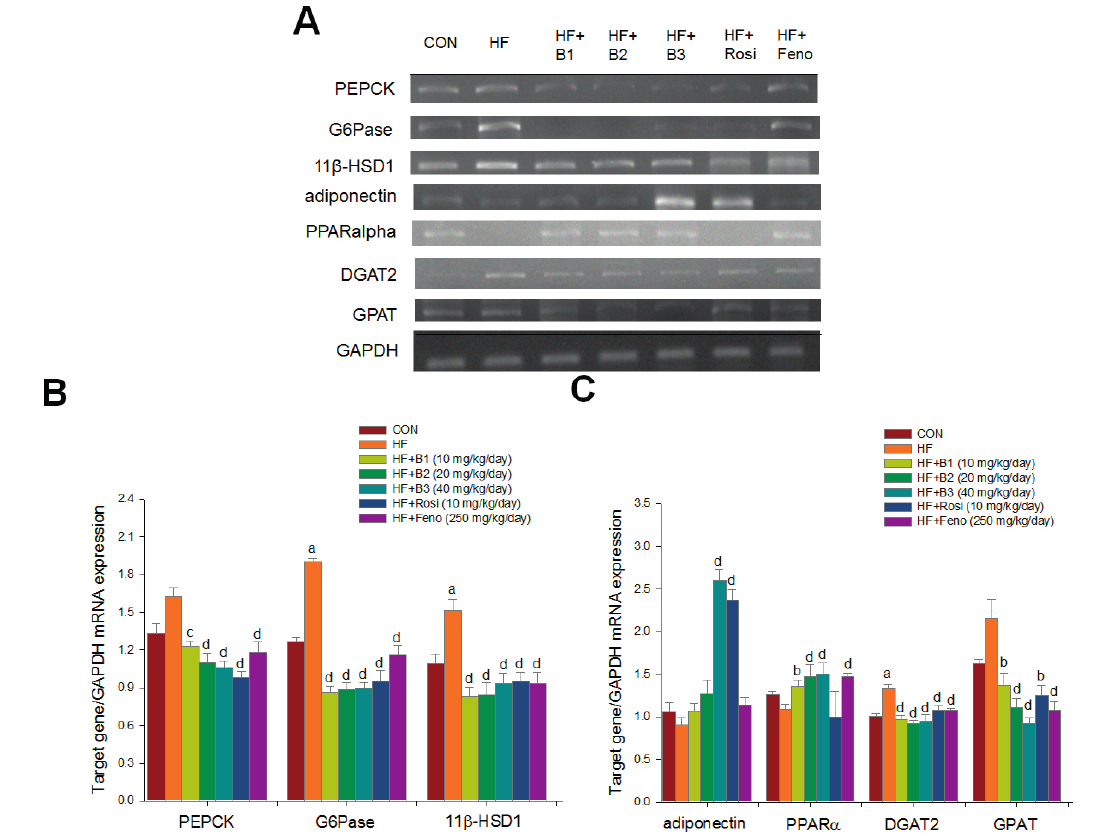
Figure 5. Semi-quantative transcription-polymerase chain reaction (RT-PCR) analysis on PEPCK, glucose-6-phosphatase (G6Pase), 11 β -HSD1, adiponectin, PPAR α ,